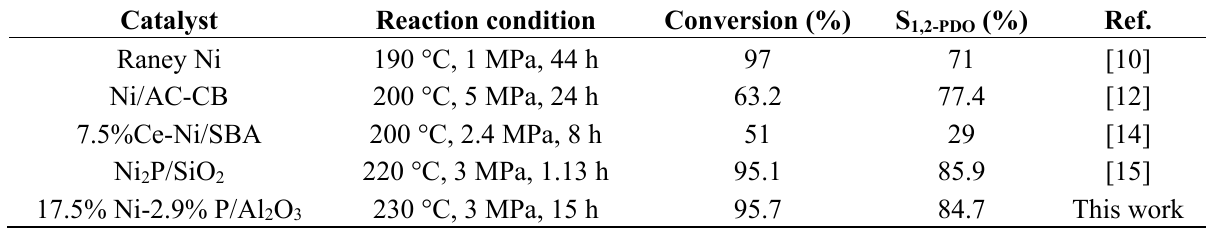
Table 5. Comparison of the Ni-based catalysts in the hydrogenolysis of